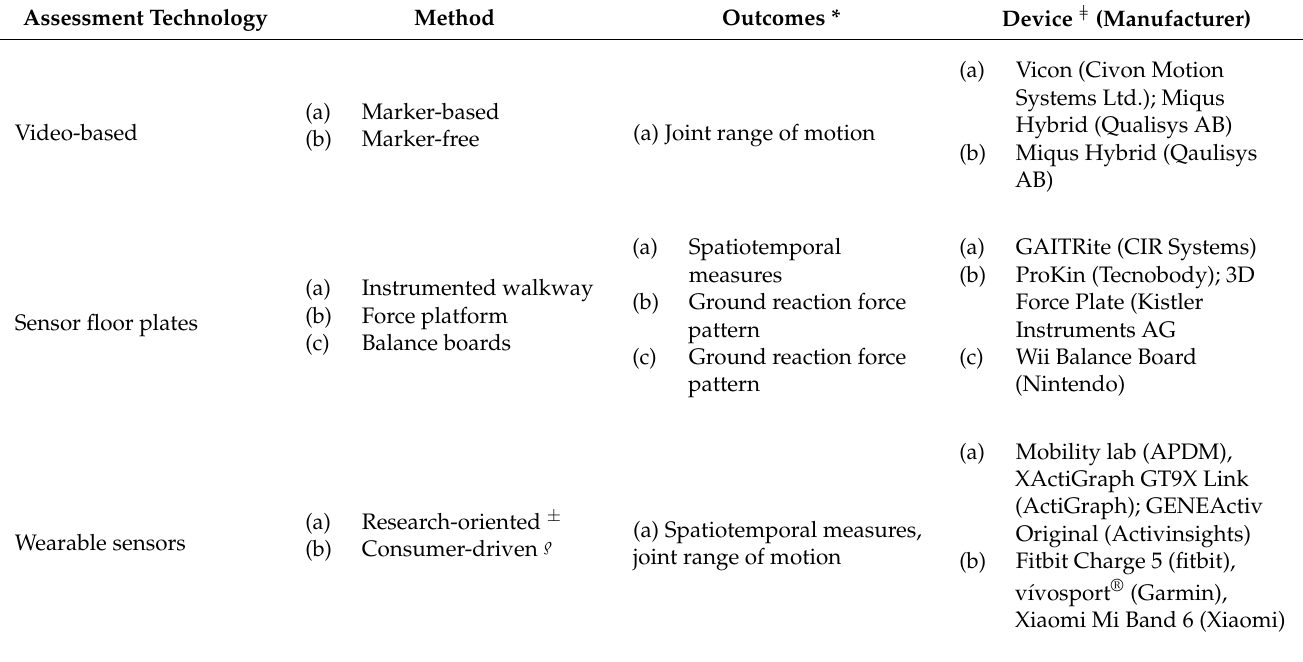
Table 3. Potential gait assessment technologies in